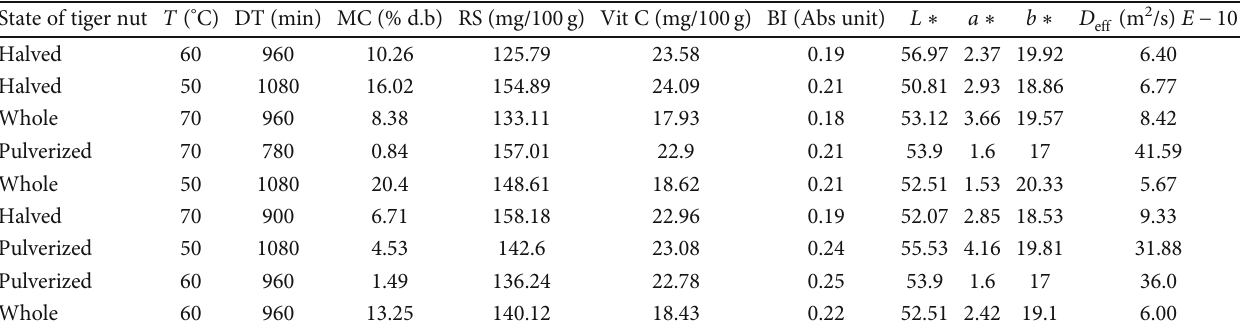
Table 3: Drying conditions and results of drying time, moisture content, reducing sugars, vitamin c browning index, colour parameters, and e ff ective moisture di ff usivity for dried tiger